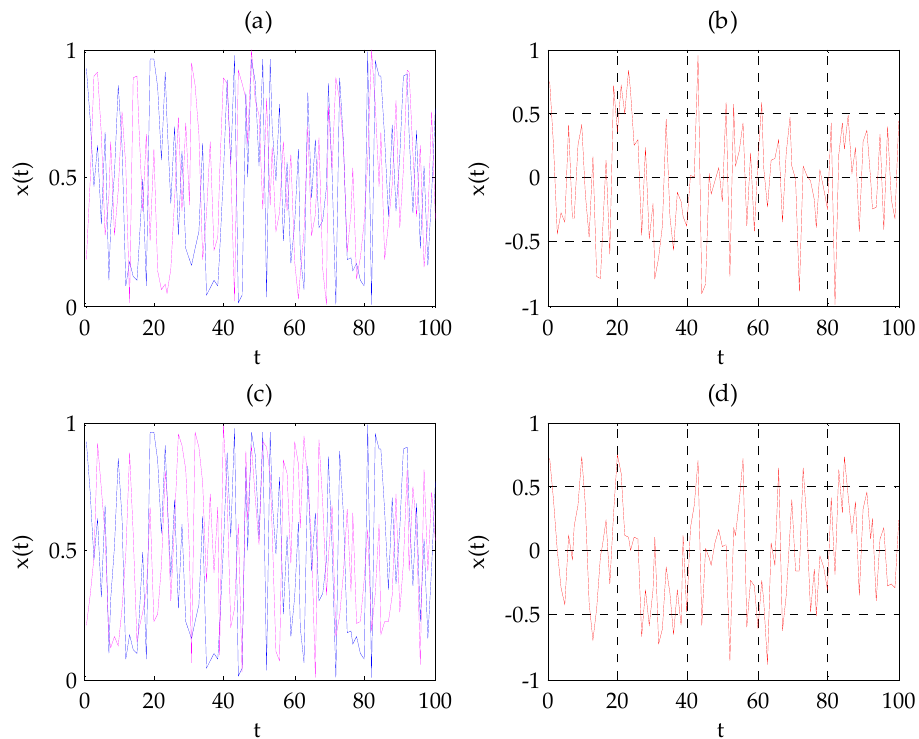
Figure 3. Schematic diagram of the sensitivity of system (2) to the initial values and system parameters: ( a ) perturbation trajectory diagram of parameter a ; ( b ) perturbation difference diagram of parameter a ; ( c ) perturbation trajectory diagram of initial value x 0 ; ( d ) perturbation difference diagram of initial value x 0 .